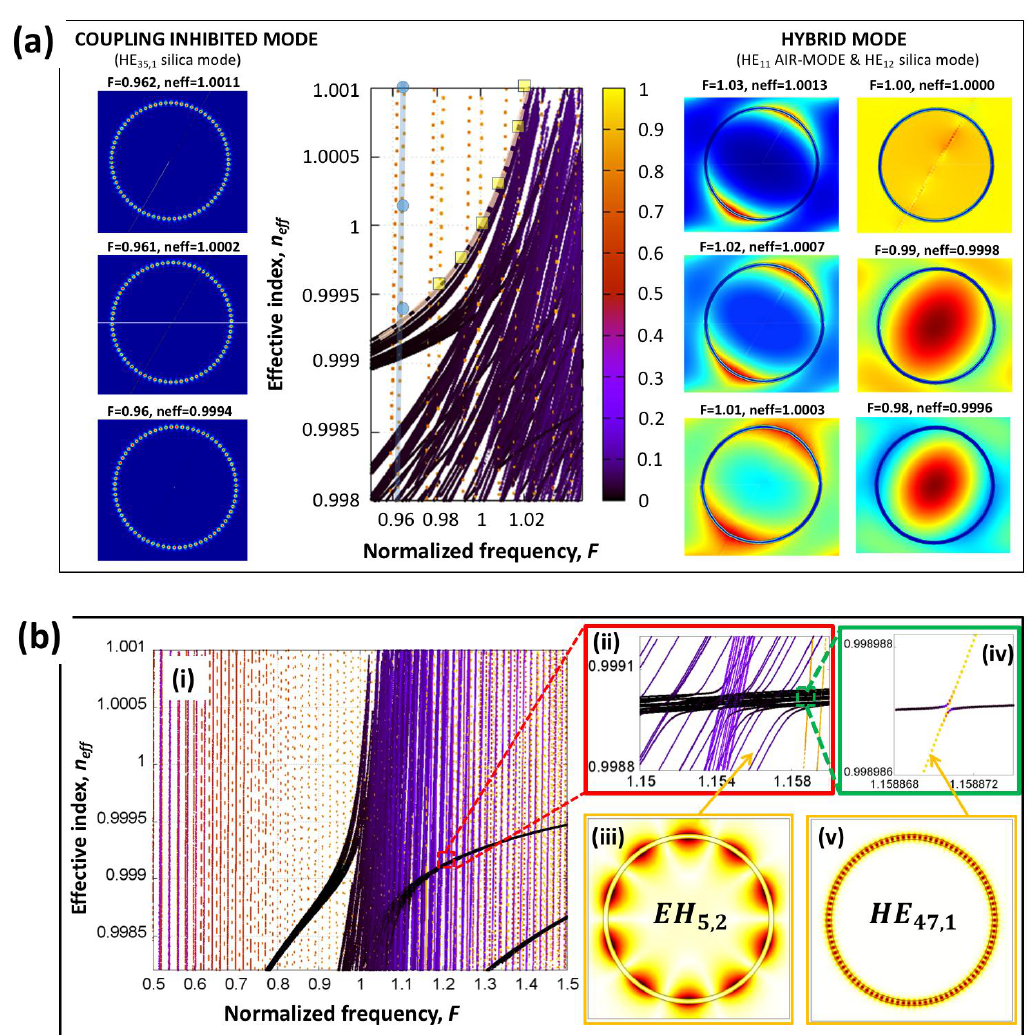
Figure 19. ( a ) Modal spectrum and lattice mode profiles near F = 1. Intensity profiles of a representative silica mode with high azimuthal number and radial number l = 1 (EH 35,1 ) and its evolution when the mode approaches HE 11 air mode ( lhs ). DOPS diagram (middle). Intensity profiles of a representative silica–air hybrid mode (HE 11 air mode and HE 12 silica mode) and its evolution when the mode approaches HE 11 air mode ( rhs ). The blue filled circles and the yellow filled squares in the DOPS diagram represent the F − n ef f locations of the silica mode on the left and the hybrid mode on the right respectively. ( b ) Zoom out view of the DOPS diagram near F = 1 (i), Close-up near an anticrossing between the HE 11 air mode and l = 2 silica mode (EH 5,2 ) (ii) and the intensity profile of the associated mode (iii). Close-up near an ultraweak anticrossing crossing between the HE 11 air mode and l = 1 high azimuthal number silica mode (HE 47,1 ) (iv), and the intensity profile of the associated mode (v). The lattice silica modes with radial number l = 1 (i.e., the EH/HE m ,1 ) are represented by orange dotted steep lines, and we distinguish them from the EH/HE m ,2 silica modes with radial number l = 2, which are represented by dark-blue colored thick steep lines. As it has been seen with the Kagome lattice [4], EH/HE m ,2 lattice silica modes populate transmission bands with l ≥ 2, whilst EH/HE m ,1 lattice silica modes populate all the transmission bands. On the lhs of the DOPS diagram, we show the mode intensity profiles of the EH 35,1 lattice silica modes at three different points of its dispersion curve (blue line crossed by blue filled circles). We can see that this mode interacts little with the air modes, illustrated by both its highly silica-localized intensity, and its dispersion curve intersecting the HE 11